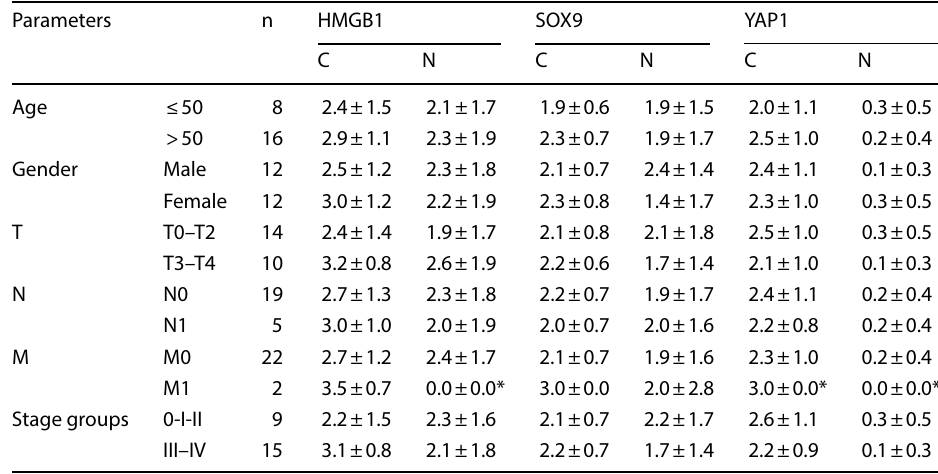
TNM classification is based on the pathological staging of T: tumor; N: node; M: metastasis Data are presented as mean ± SD. Statistical different is compared between group of parameter in each target location and * indicates statistically significant (p <